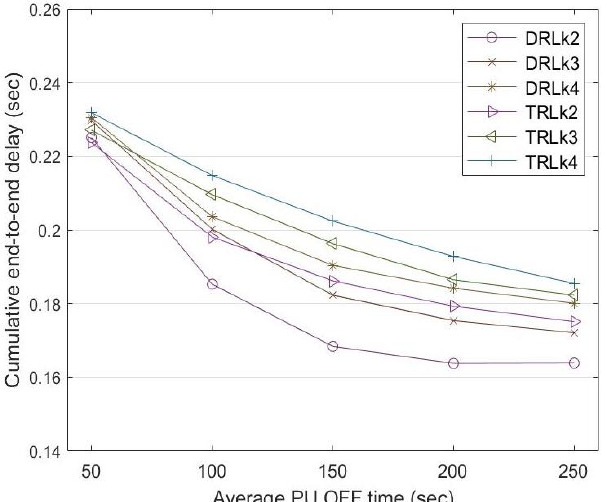
Figure 10. End-to-end delay comparison among routes k 2 , k 3 , and k 4 between DRL and TRL with α = 0.5 at a different PU OFF time.